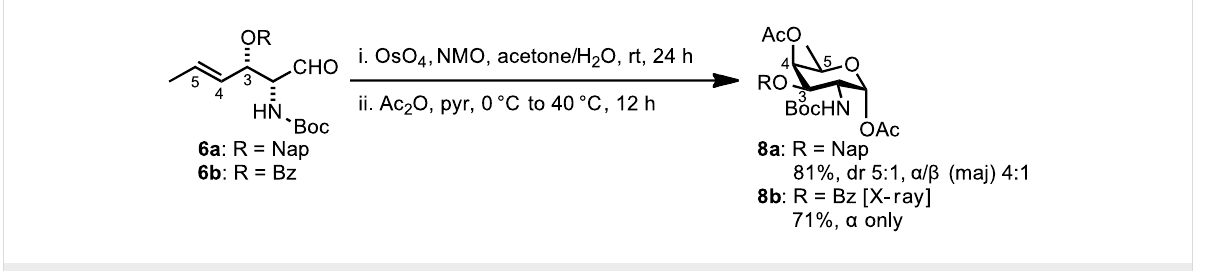
Scheme 3: Synthesis of D-fucosamine building blocks 8a and 8b .